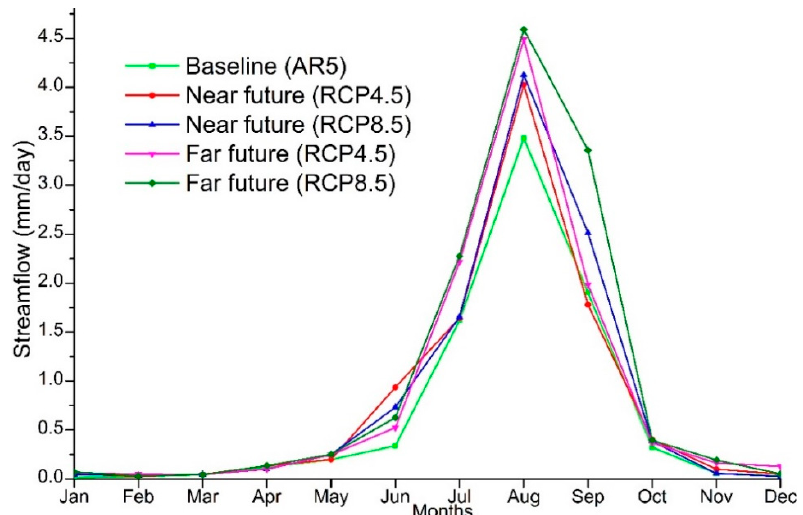
Figure 14. Projected monthly streamflow compared to the baseline: results of IPSL and MPI were averaged for RCP4.5 and RCP8.5 scenarios during the near and far future periods.